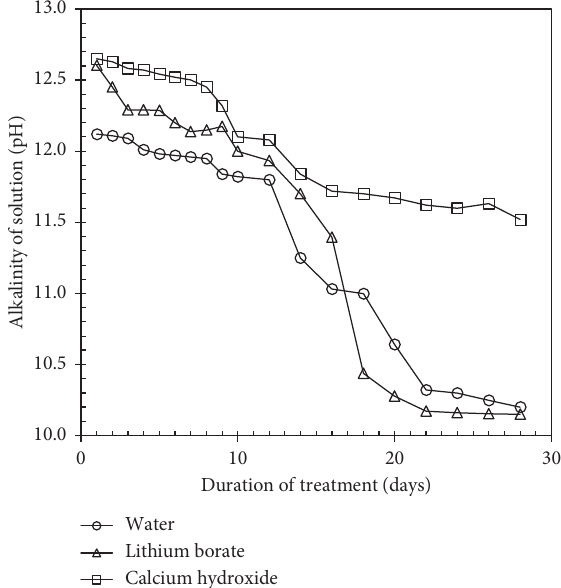
Figure 3: Electrolyte pH and voltage of circuit during